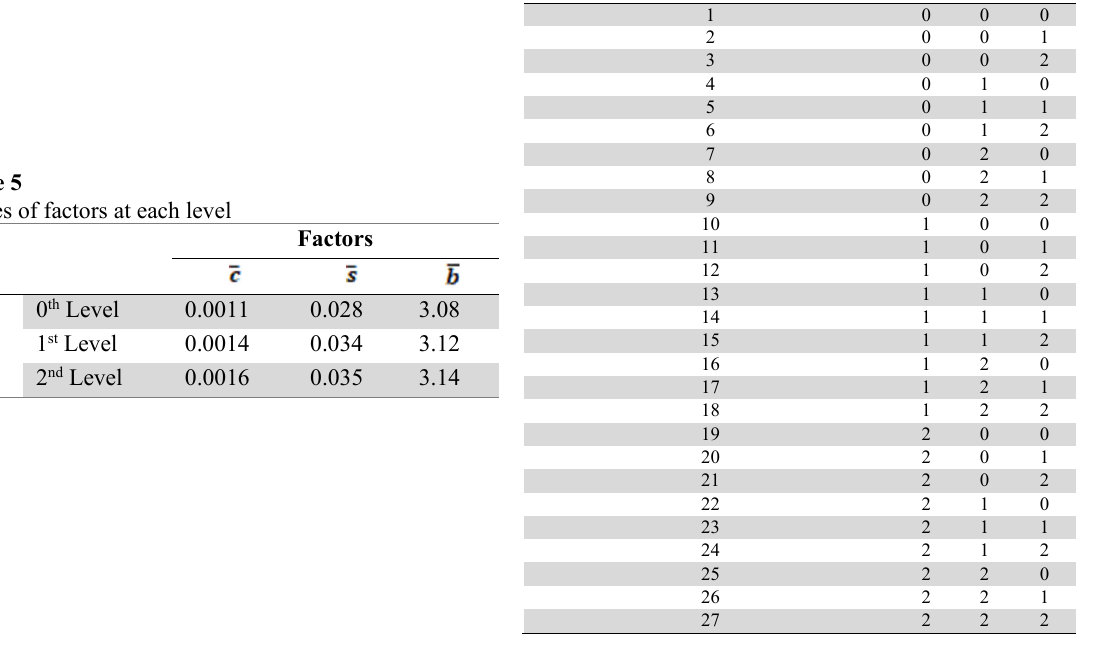
The full factorial design Treatment Condition